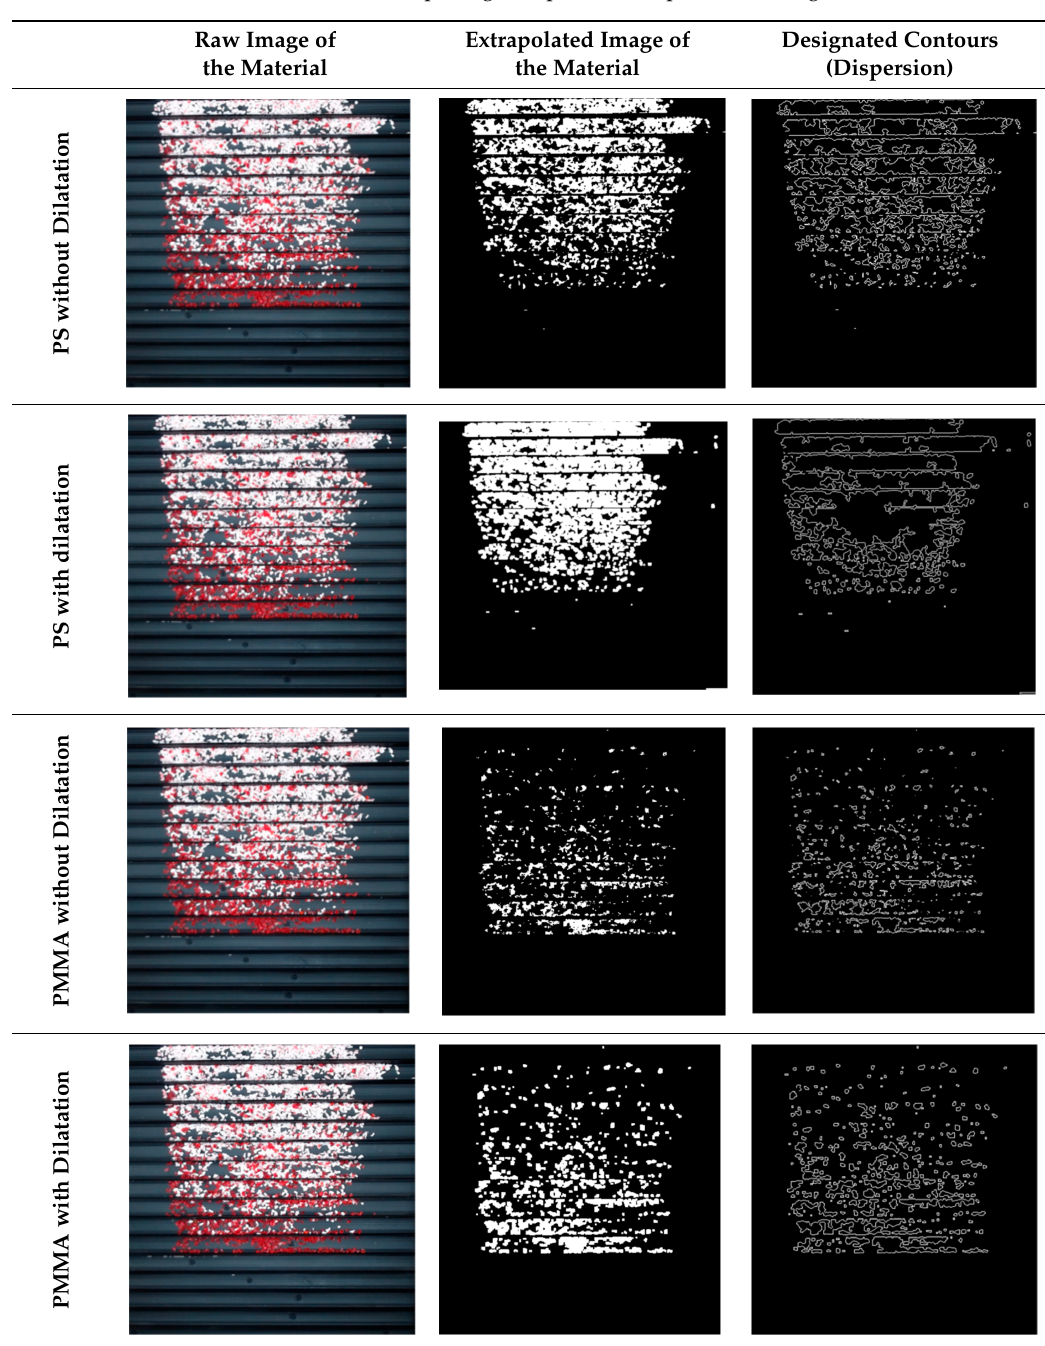
Table 2. Effect of morphological operation on processed images.